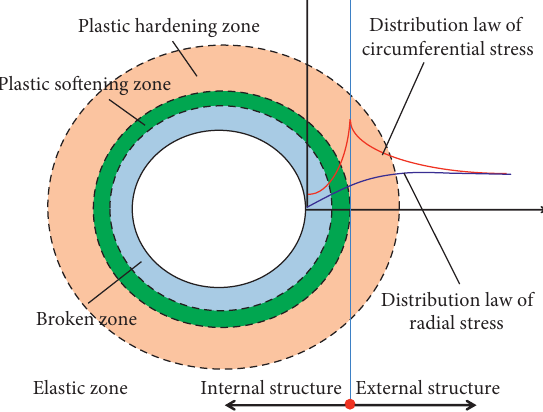
Figure 2: Schematic diagram of internal and external bearing structure division of surrounding